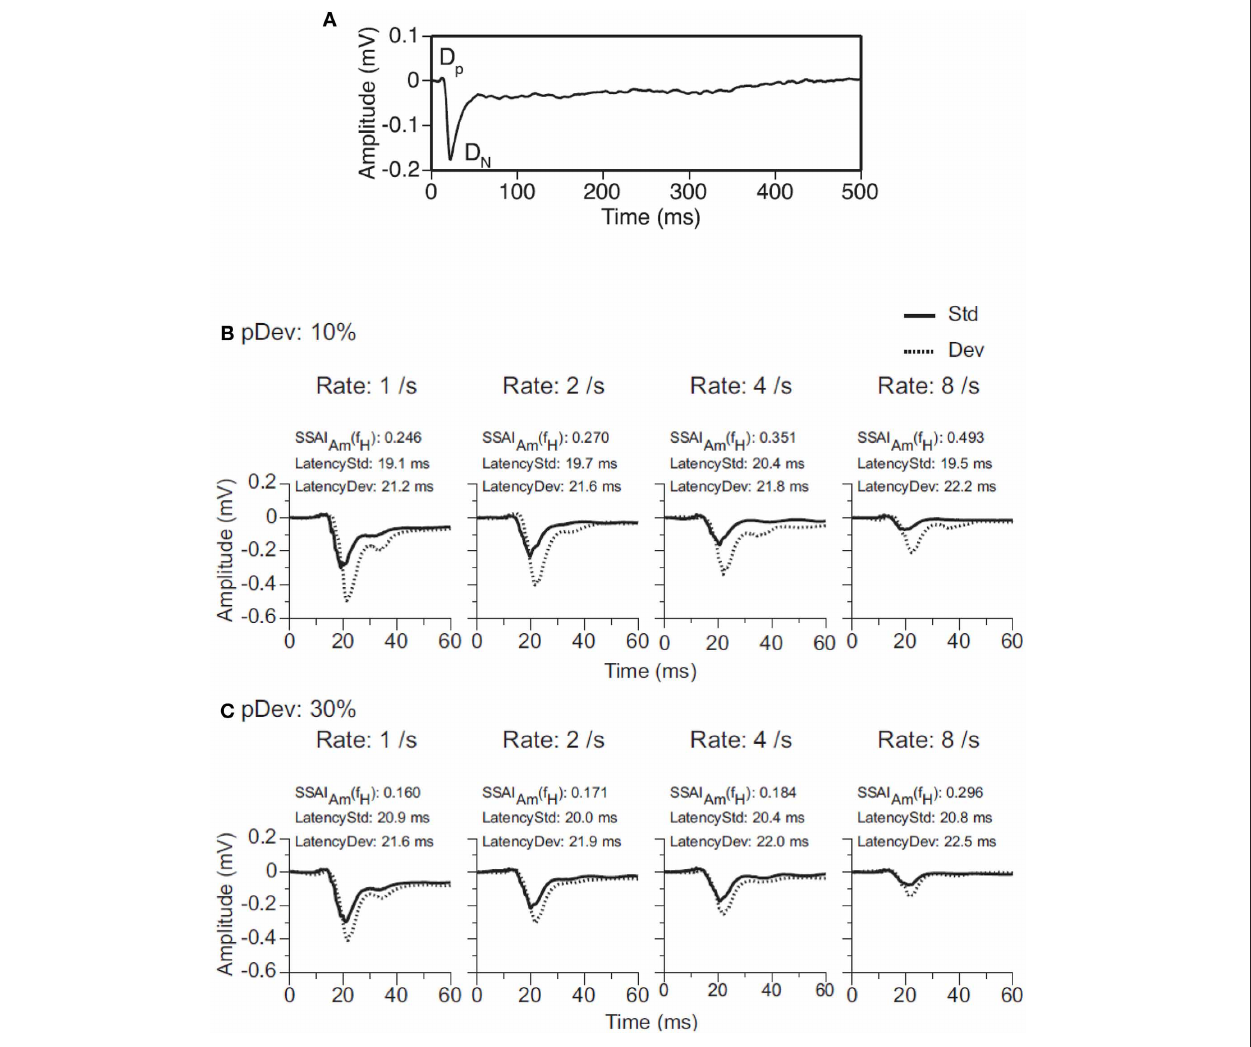
FIGURE 6 | Evoked local field potentials (LFP) recorded in the DCIC. (A) An average LFP is a waveform with a relatively small positive deflection ( D P ) followed by a large negative deflection ( D N ). Together, the two deflections are about 40ms in total duration. ( B,C ) Evoked LFPs in response to a tone burst presented as standard stimulus (Std, solid line) or deviant stimulus (Dev, dotted line) in a pair of oddball sequences with probabilities of occurrence of the deviant of 10% (panel B ) or 30%